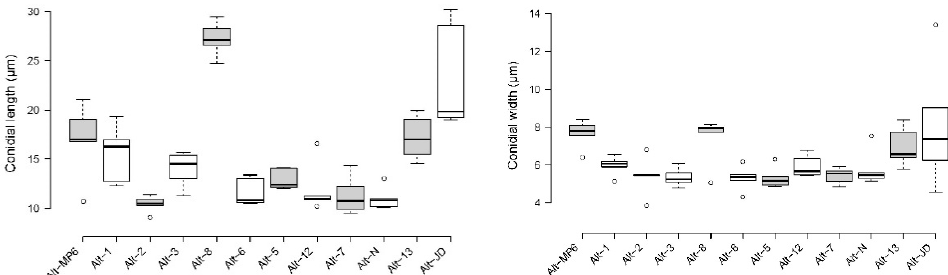
Figure 4. Box plots showing the variation in length and width of conidia produced by Alternaria isolates characterized in the current study. Center lines show the medians; box limits indicate the 25th and 75th percentiles, as determined by R software; whiskers extend 1.5 times the interquartile range from the 25th and 75th percentiles; outliers are represented by dots. n = 5 sample points. Colletotrichum isolates produced cylindrical, hyaline, single-celled conidia. Conidia of isolates Col-1, 2, 3, 9, 11, 12, 13, 14, 15, 17, 18 and 25 were rounded at both ends, while conidia of the rest of the isolates were pointed at one end and rounded at the other. Conidial length ranged from 7.9 to 17 µ m and width from 2.1 to 3.2 µ m, with a length-to-width ratio ranging between 2.7 and 5.3 (Figure 5, Supplementary Table S5).